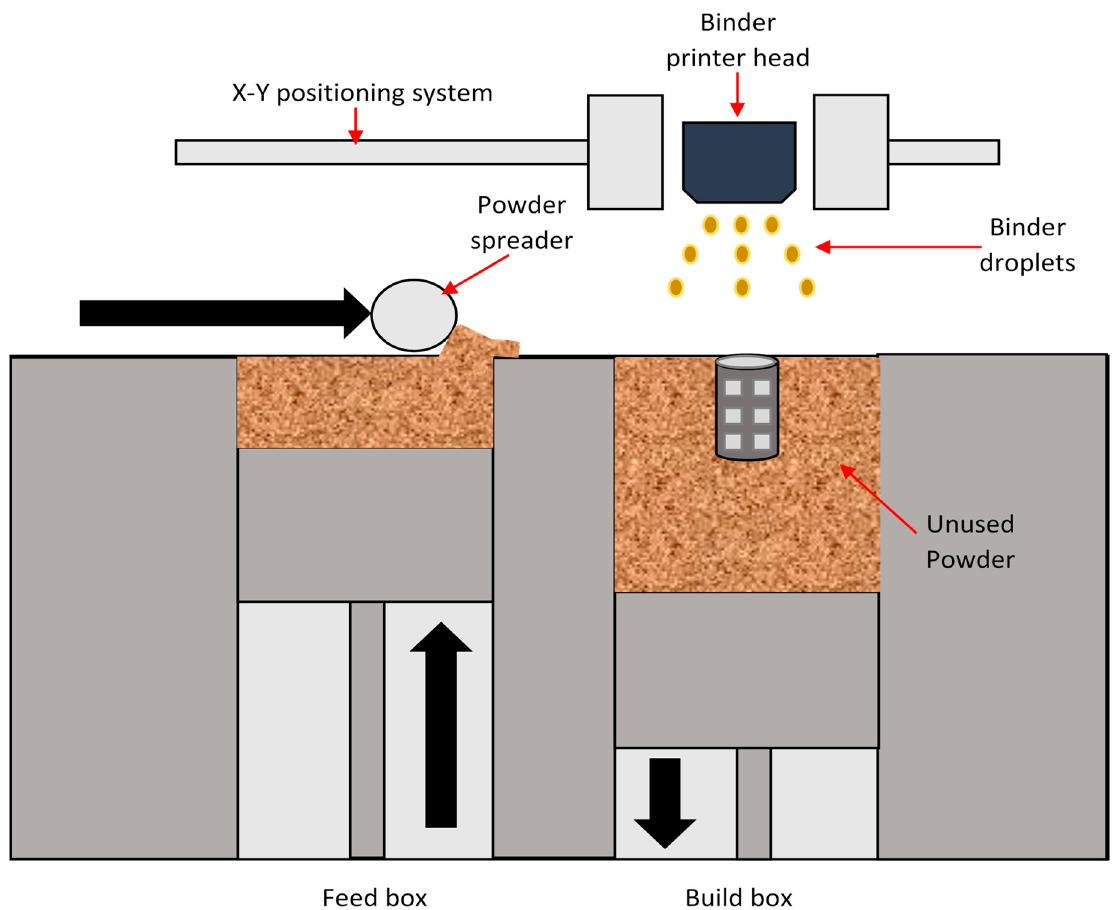
Figure 1. Schematic representation of FFF.